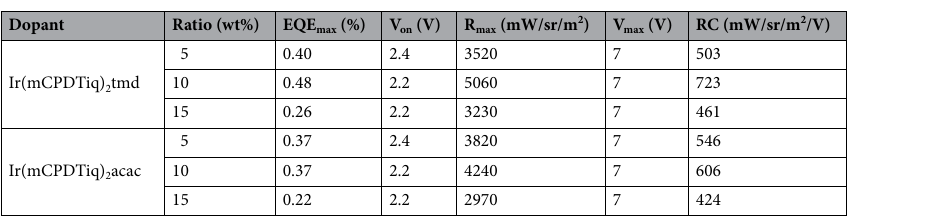
Table 2. Characteristics of NIR OLEDs according to ligand and doping ratio.